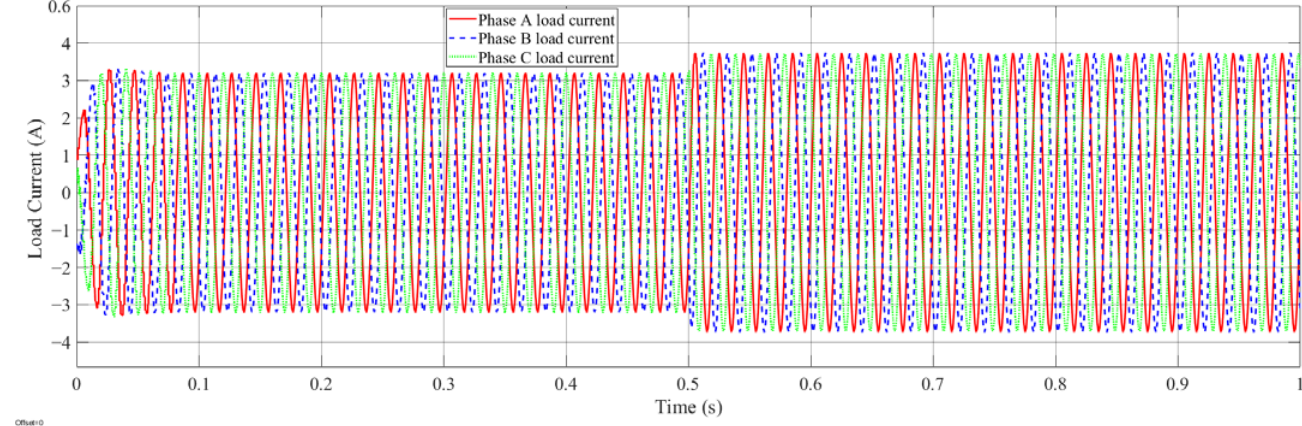
Figure 12. Output voltage for inductive load in the d - q frame.